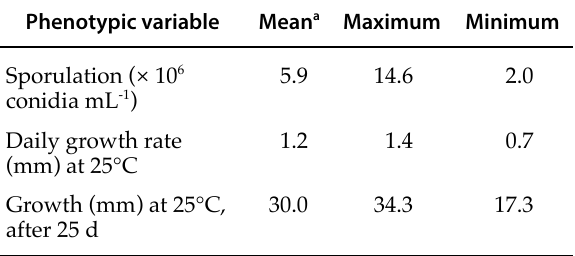
Table 5. Mean, maximum and minimum values of the phe - notypic variables studied for all the Phaeomoniella chlamyd- ospora